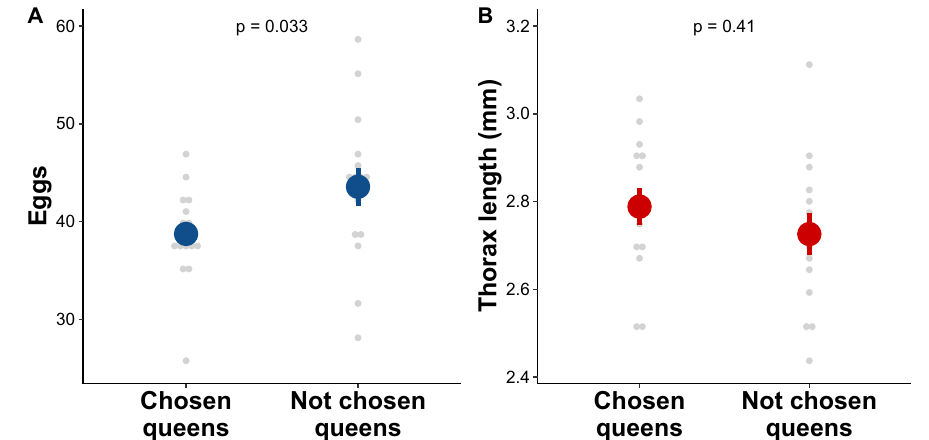
Figure 5. Difference between queens that were chosen and not chosen in the choice tests in ( A ) maximum number of eggs recorded and ( B ) thorax length (mean ±